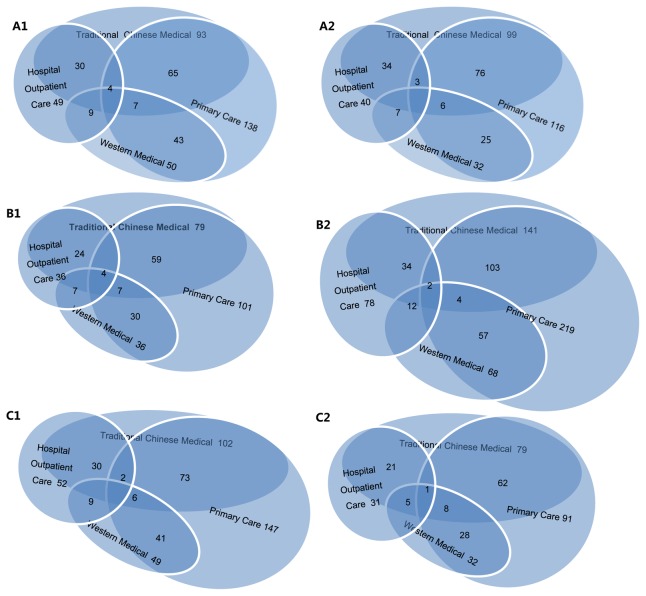
The proportion of subjects who did not experience health problems in four health-care settings.Four health care settings include traditional Chinese medical care, western medical care, primary care and hospital-based outpatient care. A1 is female, A2 is male, B1 is age under 55 years, B2 is age above 55 years, C1 is resident with “Hukou”, C2 is migrant. The values are based on 1,000 persons.